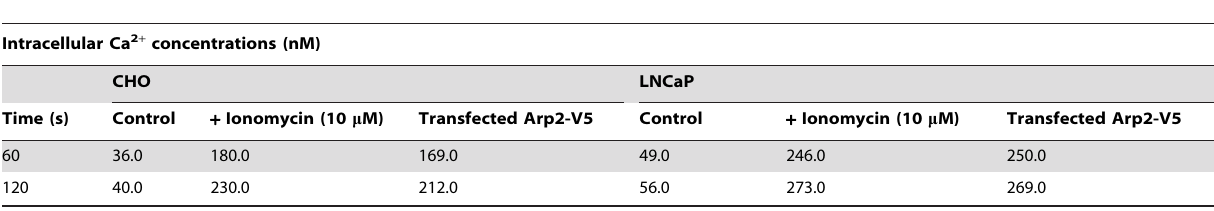
Table 1. Intracellular Ca 2 + concentrations in whole cell suspensions using